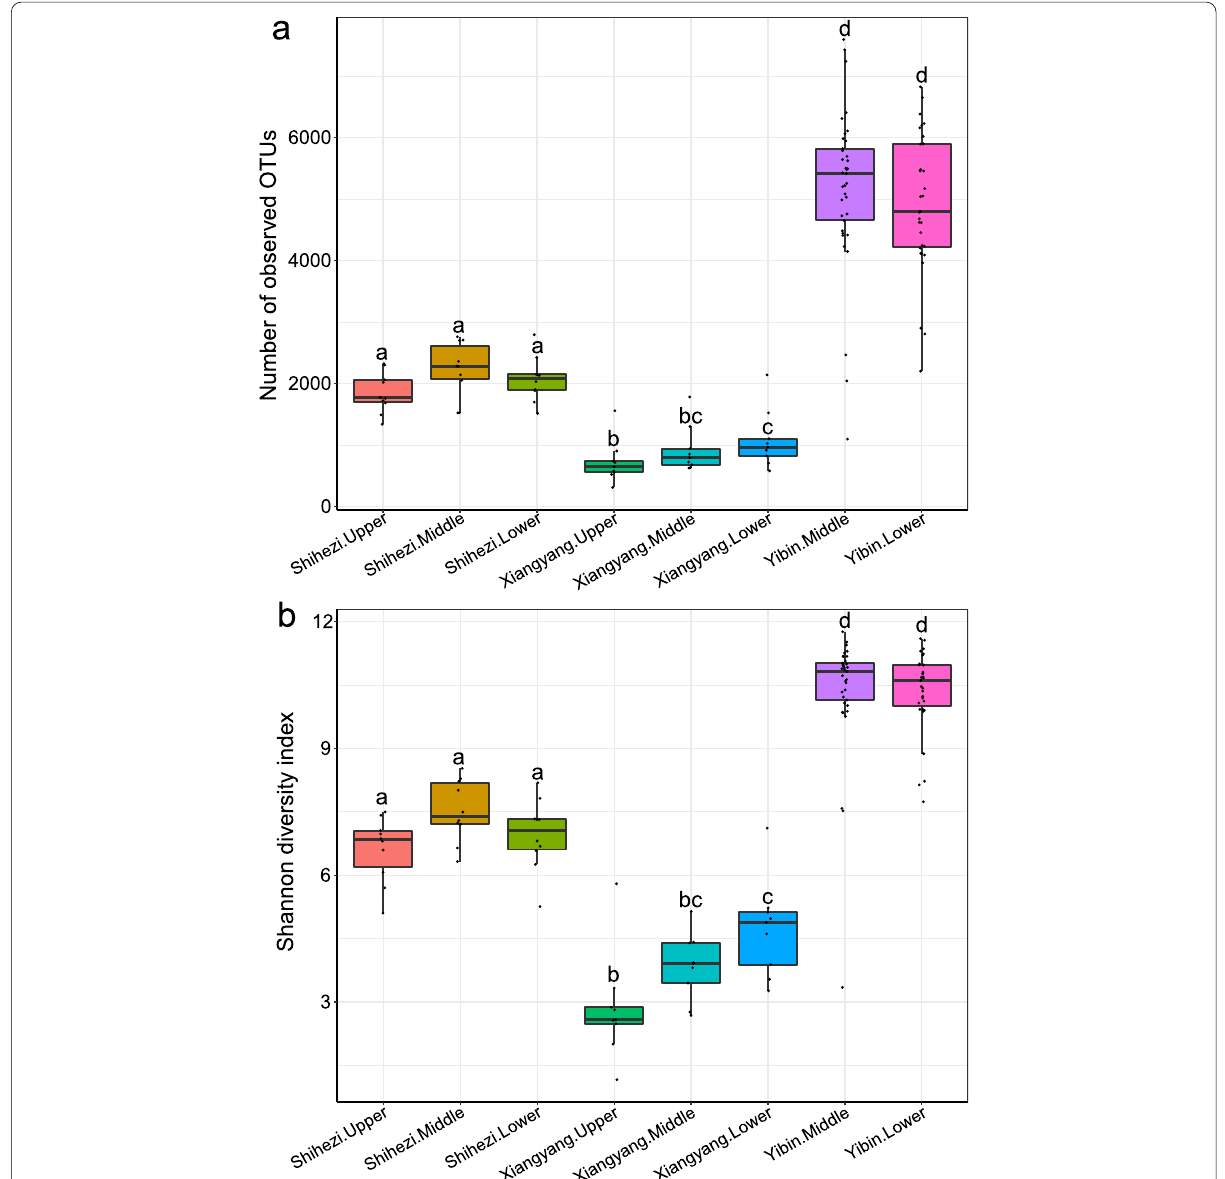
Fig. 2 Comparison of α-diversity indexes ( a number of observed OTUs; b Shannon diversity index) for bacteria in samples collected from different regions and depths. Dots represent specific values for each